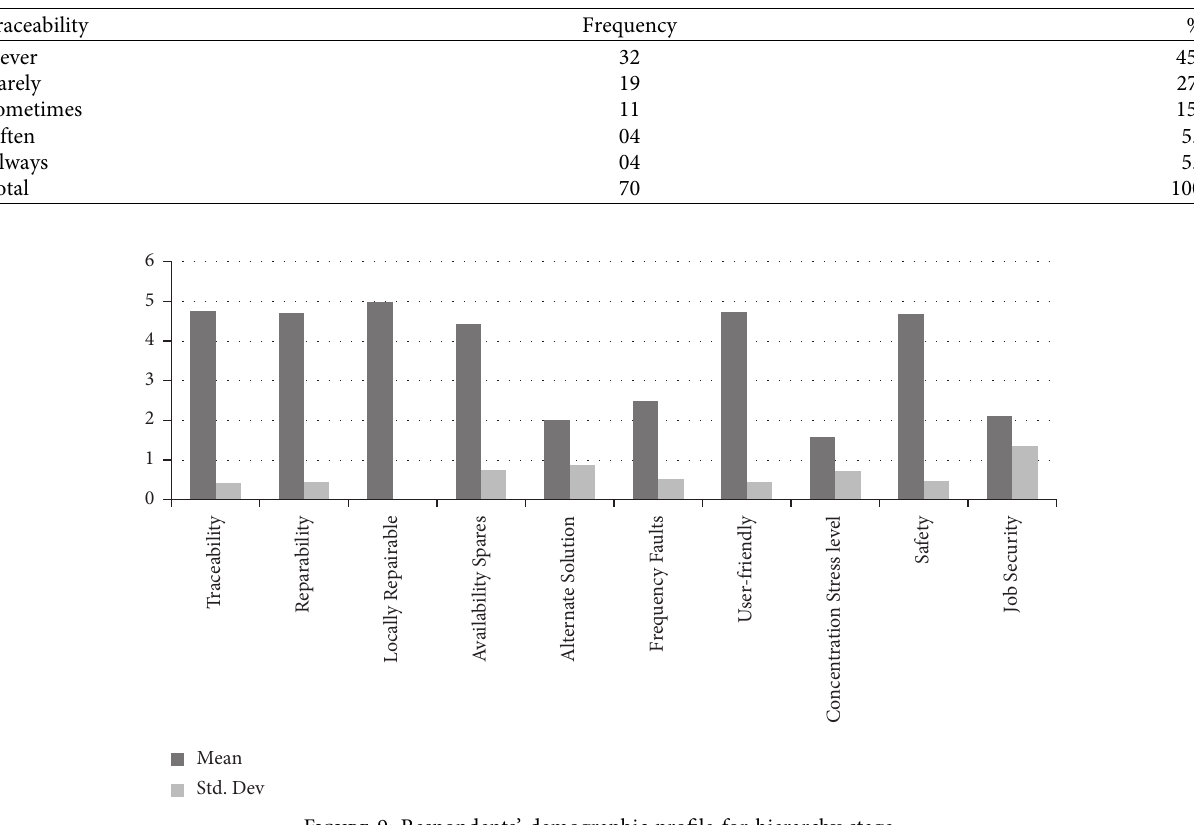
Figure 9: Respondents’ demographic profile for hierarchy